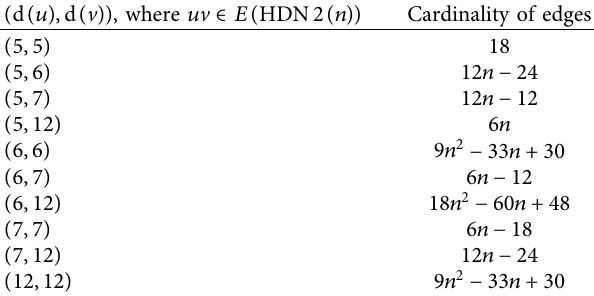
Table 4: Edge partition of HDN 2 ( n ) .